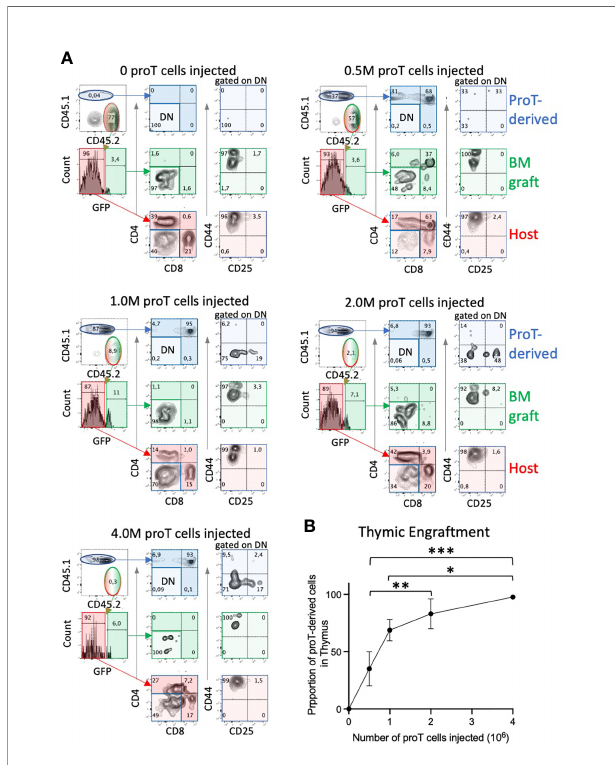
FIGURE 3 | Thymic engraftment of aged mice is dependent on proT cell dosage. Conditioned aged B6 CD45.2 mice were i.v. injected with 1 x 10 6 TDBM from CD45.2 GFP + mice and an increasing number of proT cells, in vitro -generated from CD45.1 mice, ranging from 0.5, 1, 2 and 4 x10 6 . Thymuses were harvested on D14 and assessed for the presence of T cell markers using fl ow cytometry. Representative plots are shown in (A) . CD44 vs. CD25 panels were gated on CD4 - CD8 - DN cells. Percentage of thymic cells derived from CD45.1 + proT cells are shown in graph in (B) (n=4; error bars depict SEM; * p <0.05, ** p <0.01, *** p <0.001. analyzed by two-way ANOVA). ns, not signi fi